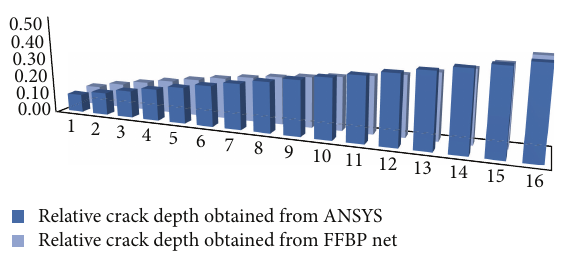
Figure 16: Comparison of result of relative crack depth between ANSYS and RBF network.